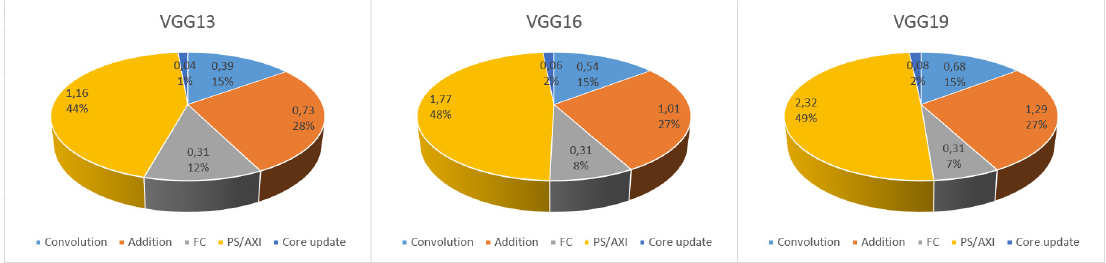
Figure 15. The comparison of relative latency required to execute VGG13/16/19 on mNet2FPGA